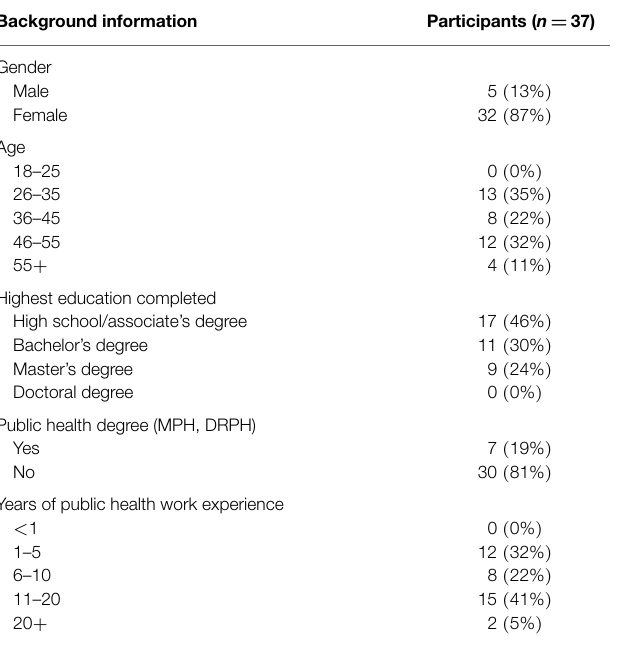
TABLE 1 | Demographics of Phase 2 participants ( n = 37)